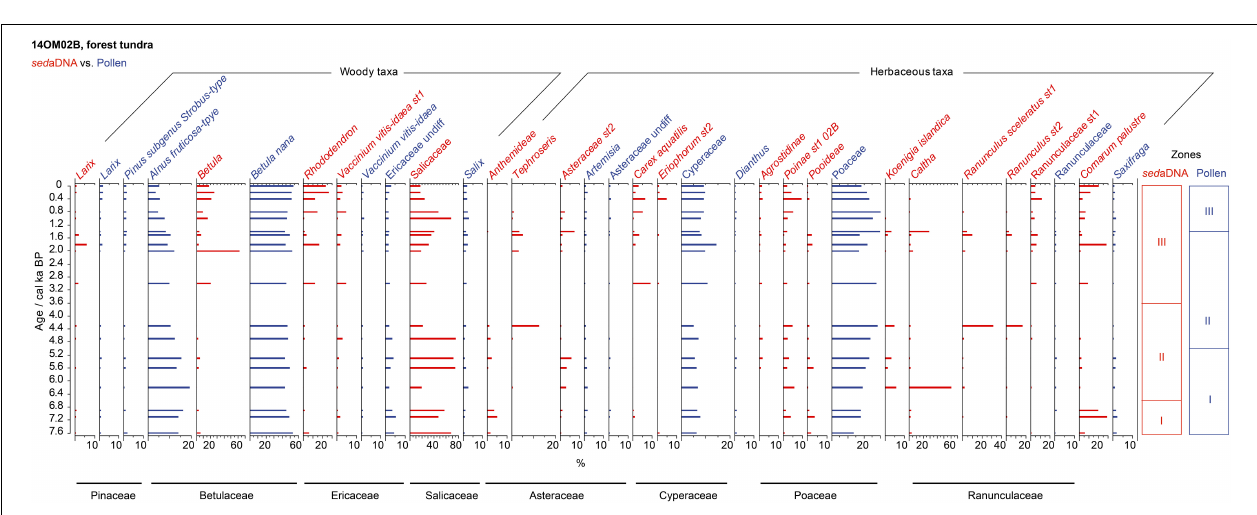
FIGURE 5 | Percentages of selected taxa/sequences over the past 7.6 ka from the forest-tundra site (14OM02B) in the Omoloy region used in our statistical analyses, shown as red bar plots of relative read abundance of seda DNA and blue bar plots of pollen percentages. The families detected by both of sedaDNA and pollen analyses are marked as black lines. CONISS zones for each proxy are shown on the